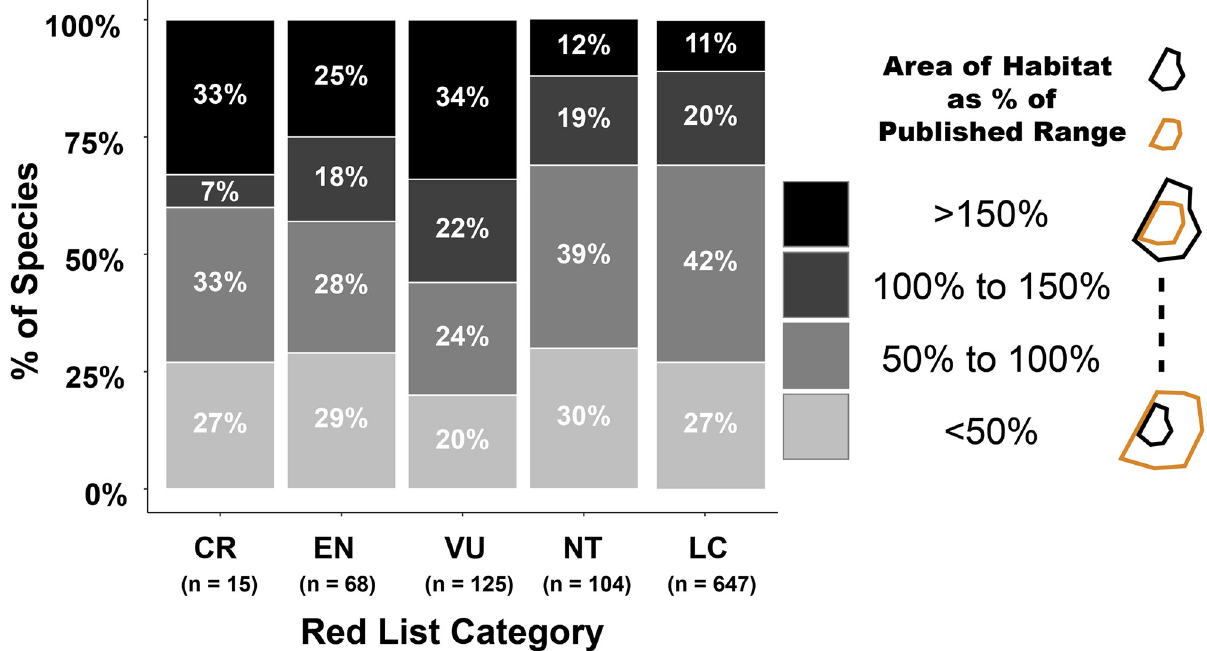
Fig 4. Area of Habitat estimates in relation to published range sizes for species in different IUCN Red List categories. Bars show the proportions of Critically Endangered (CR), Endangered (EN), Vulnerable (VU), Near Threatened (NT), and Least Concern (LC) species with different percentage values for Area of Habitat divided by the published range. The lightest colours represent species with Area of Habitat that is less than 50% of the published range while the darkest colours represent species with Area of Habitat more than 150% larger than the published range size. Black polygons represent Area of Habitat and gold polygons represent published